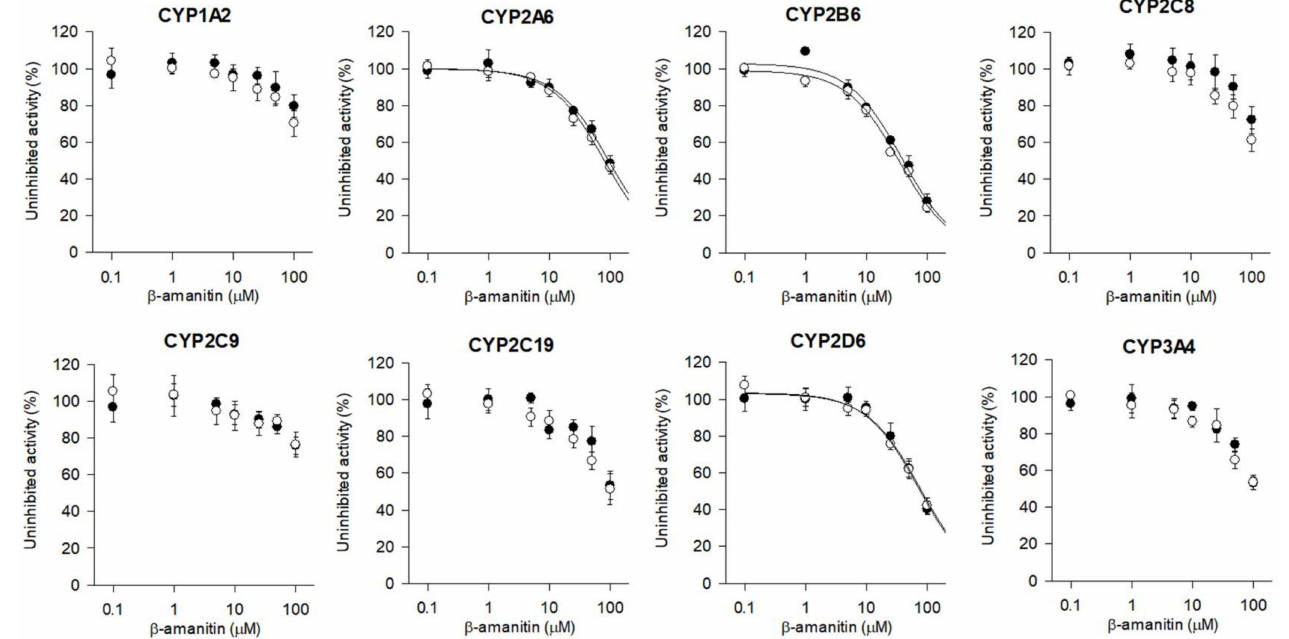
Figure 7. Inhibitory of eight major CYP enzyme activities by β -amanitin with ( without ( ) 30 min preincubation of NADPH in human liver microsomes. Phenacetin O- deethylation for CYP1A2, coumarin 7 (cid:48) -hydroxylation for CYP2A6, bupropion hydroxylation for CYP2B6, amodiaquine N -deethylation for CYP2C8, diclofenac 4 (cid:48) -hydroxylation for CYP2C9, [ S ]- mephenytoin 4 (cid:48) -hydroxylation for CYP2C19, bufuralol 1 (cid:48) -hydroxylation for CYP2D6, and midazolam 1 (cid:48) -hydroxylation for CYP3A4 were measured by LC-MS/MS. Each data point represents mean ± SD ( n = 3). β -amanitin did not inhibit UGT1A1-catalyzed SN-38 glucuronidation, UGT1A3-catalyzed chenodeoxycholic acid 24-acyl- β -glucuronidation, UGT1A4-catalyzed trifluoperazine N - β - D-glucuronidation, UGT1A6-catalyzed N -acetylserotonin β -D-glucuronidation, UGT1A9- catalyzed mycophenolic acid β -D-glucuronidation, or UGT2B7-catalyzed naloxone 3- β -D- glucuronidation at 100 µ M in HLMs (Figure 1